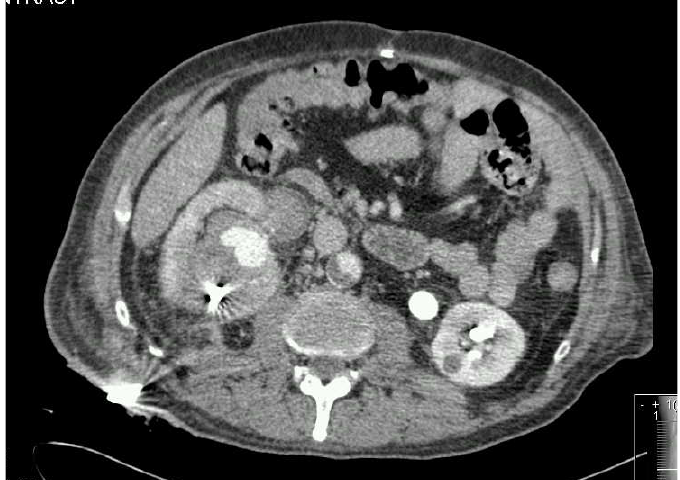
FIGURE. 1 : CTA scan showing renal lower pole pseudoaneurysm (white